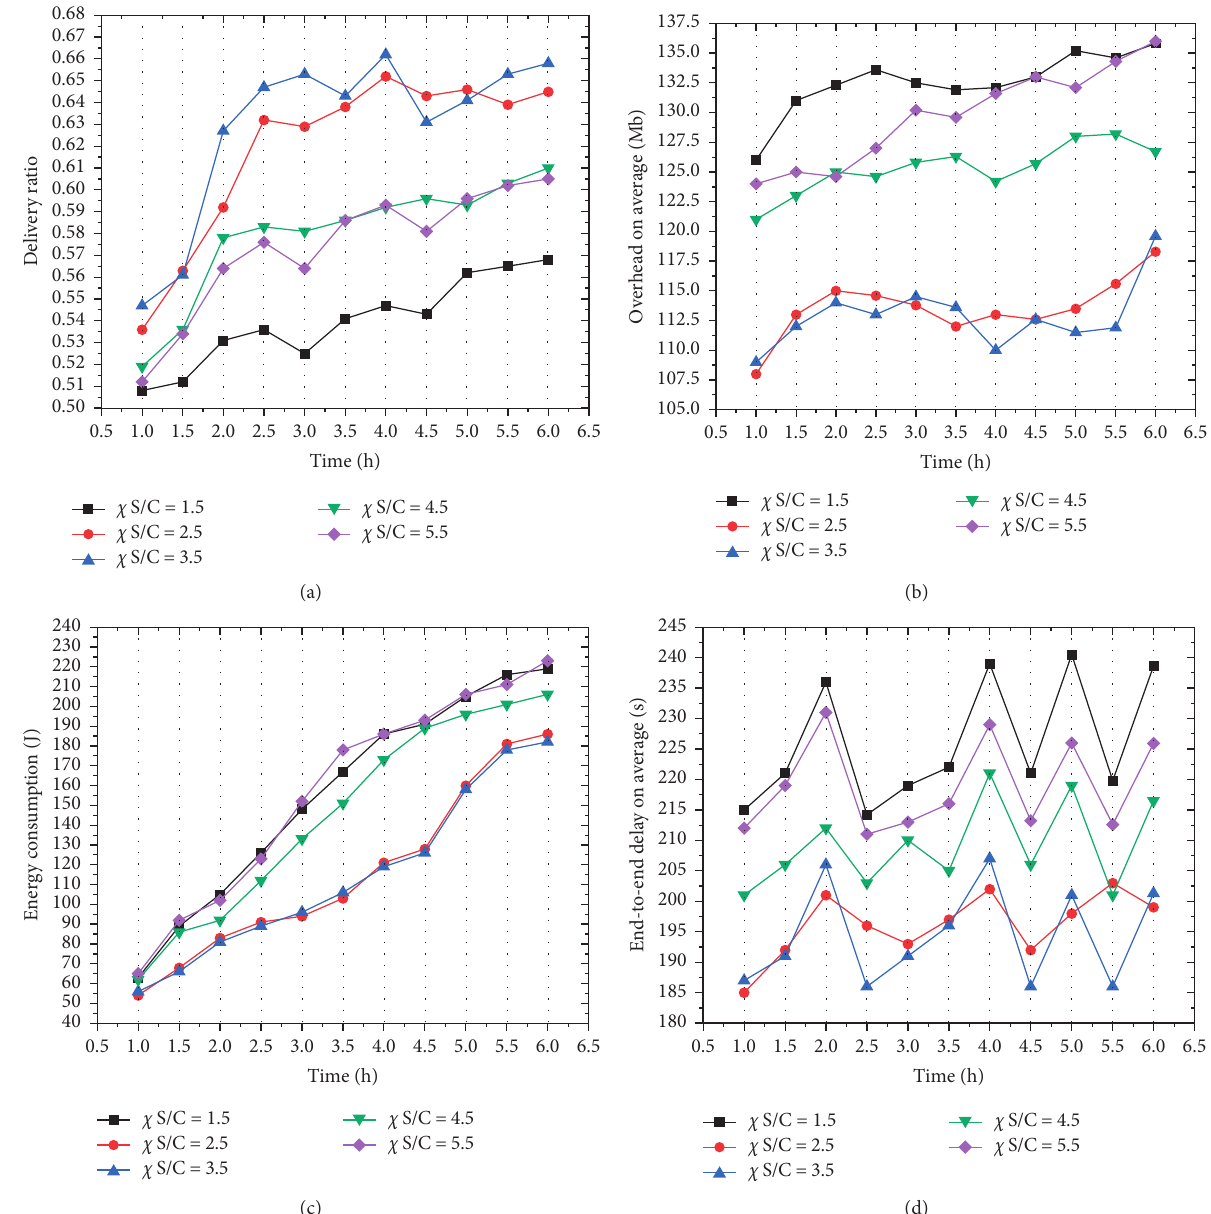
Figure 11: The relationship between each parameter value and time under different specific thresholds χ